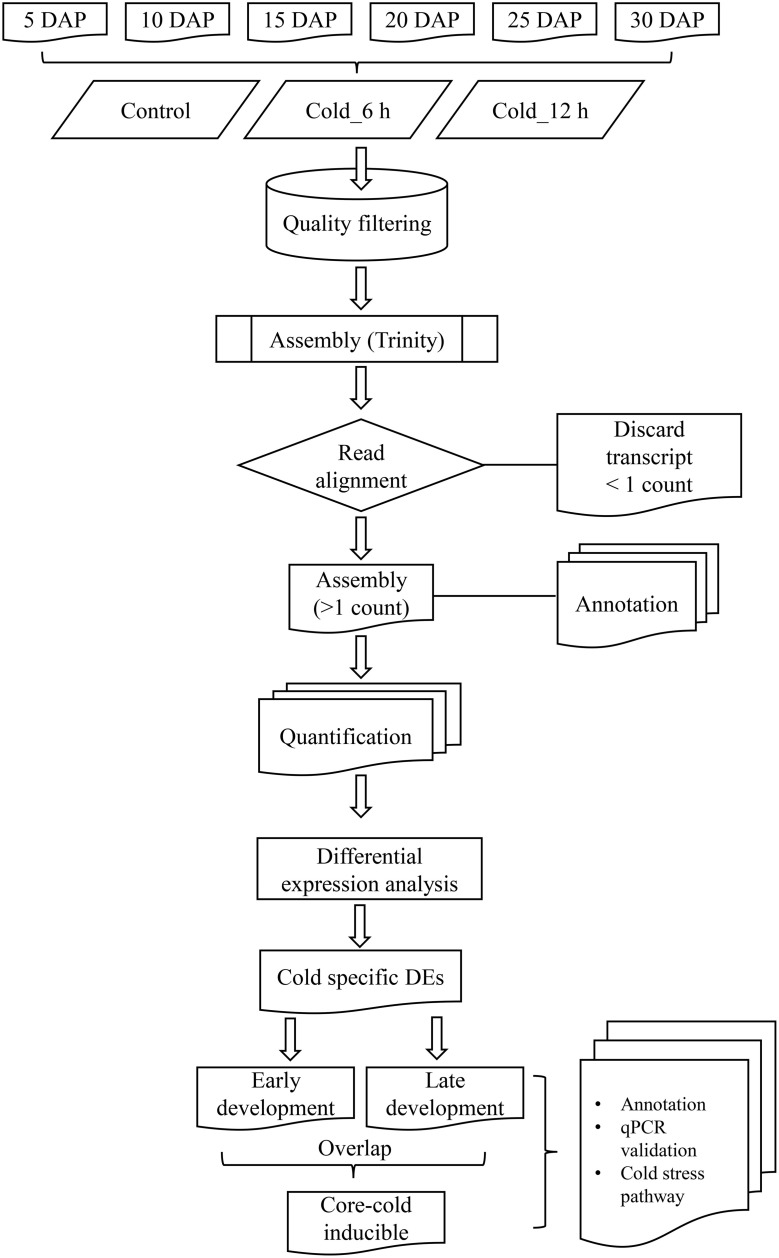
Flowchart representing computational pipeline employed for analysis of transcriptome sequenced from B. juncea siliques.